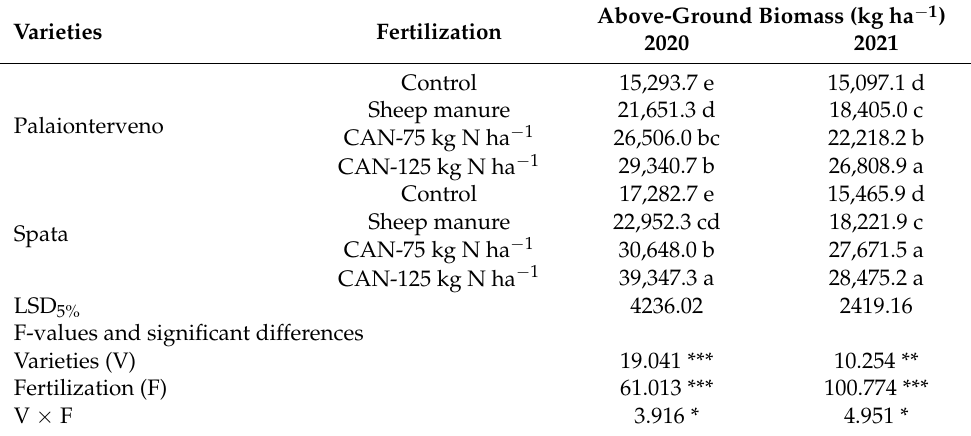
Table 3. Interaction effects between variety and fertilization on aboveground dry biomass of milk thistle crop.